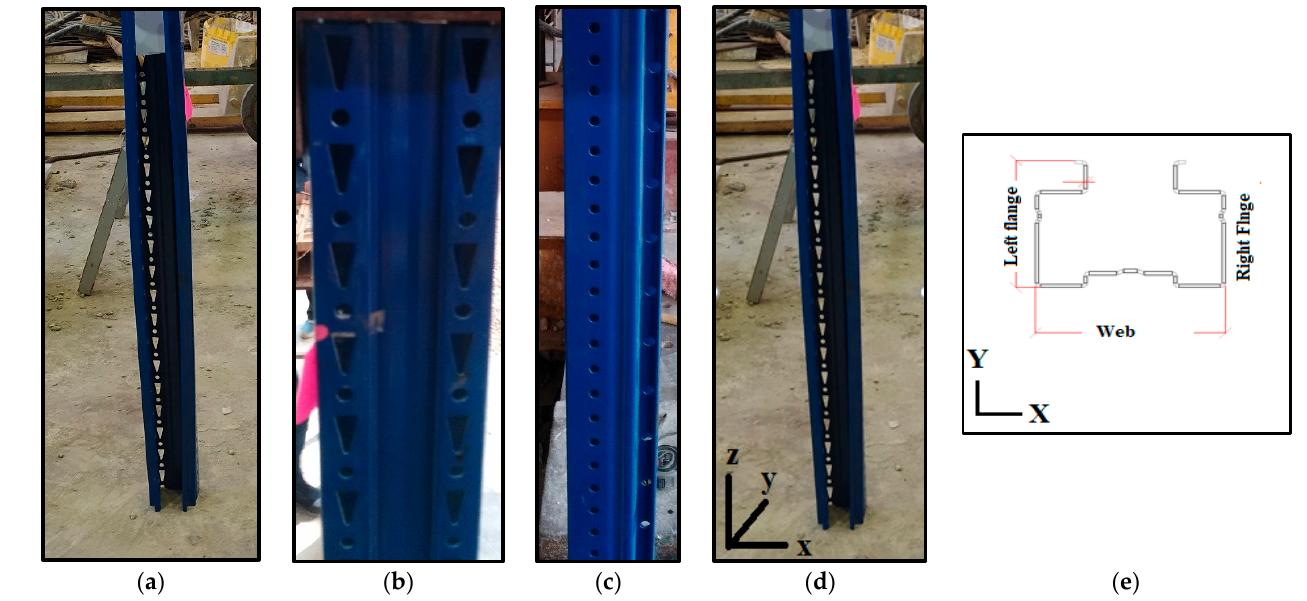
Figure 1. Tested specimen details. ( a ) Specimen shape; ( b ) Web perforations; ( c ) Flange perforations; ( d ) Directions; ( e ) Cross ‐ section shape.